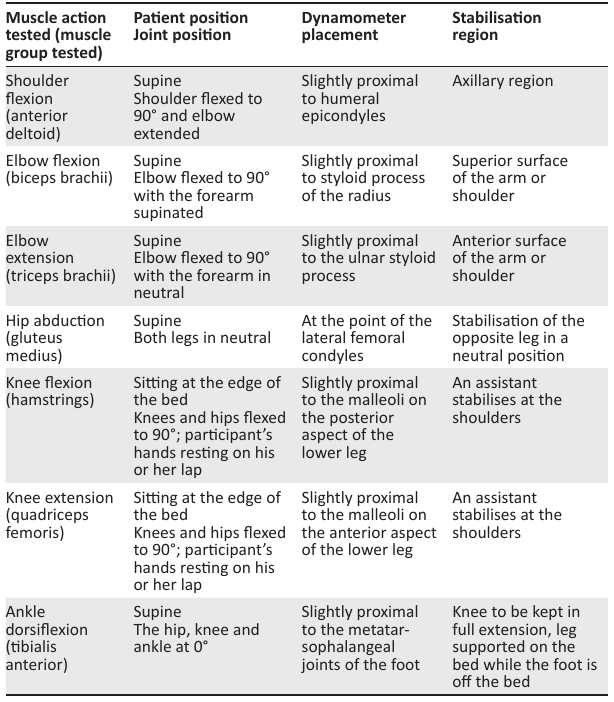
TABLE 1: Peripheral muscle strength testing positions and muscle groups